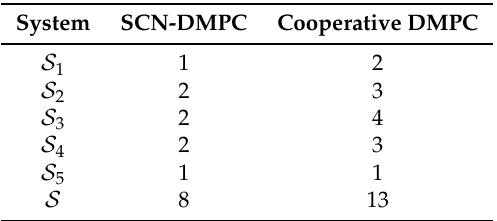
Table 2. Comparison of system connectivity with different control methods.